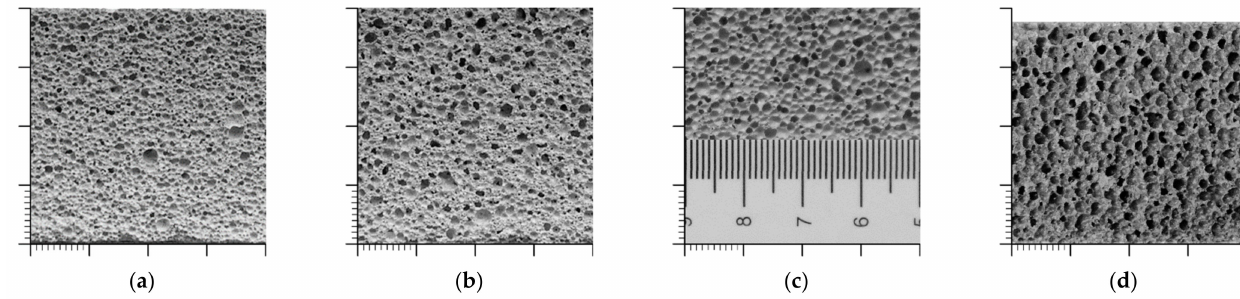
Figure 4. Foam classes showing different foam morphologies: ( a ) B-type, ( b ) A-type, ( c ) C-type, and ( d ) D-type. Scale size shown in ( c ): major ticks represent cm while minor ones represent mm.